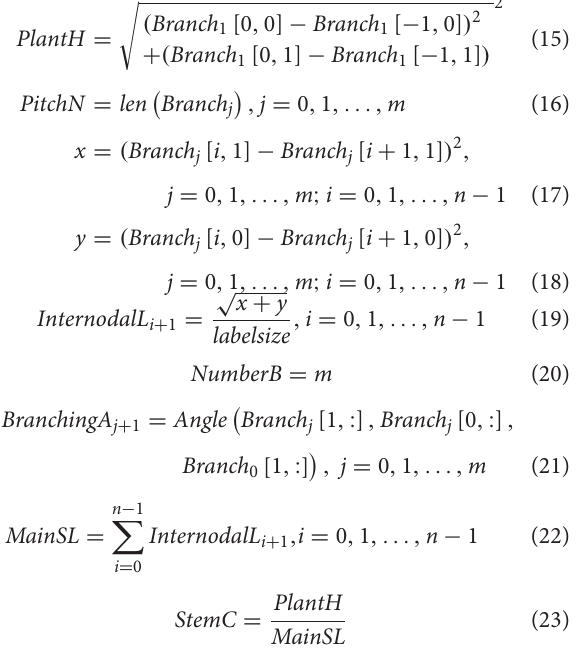
stem node. Algorithm 2 ( Figure 4B ) explains the